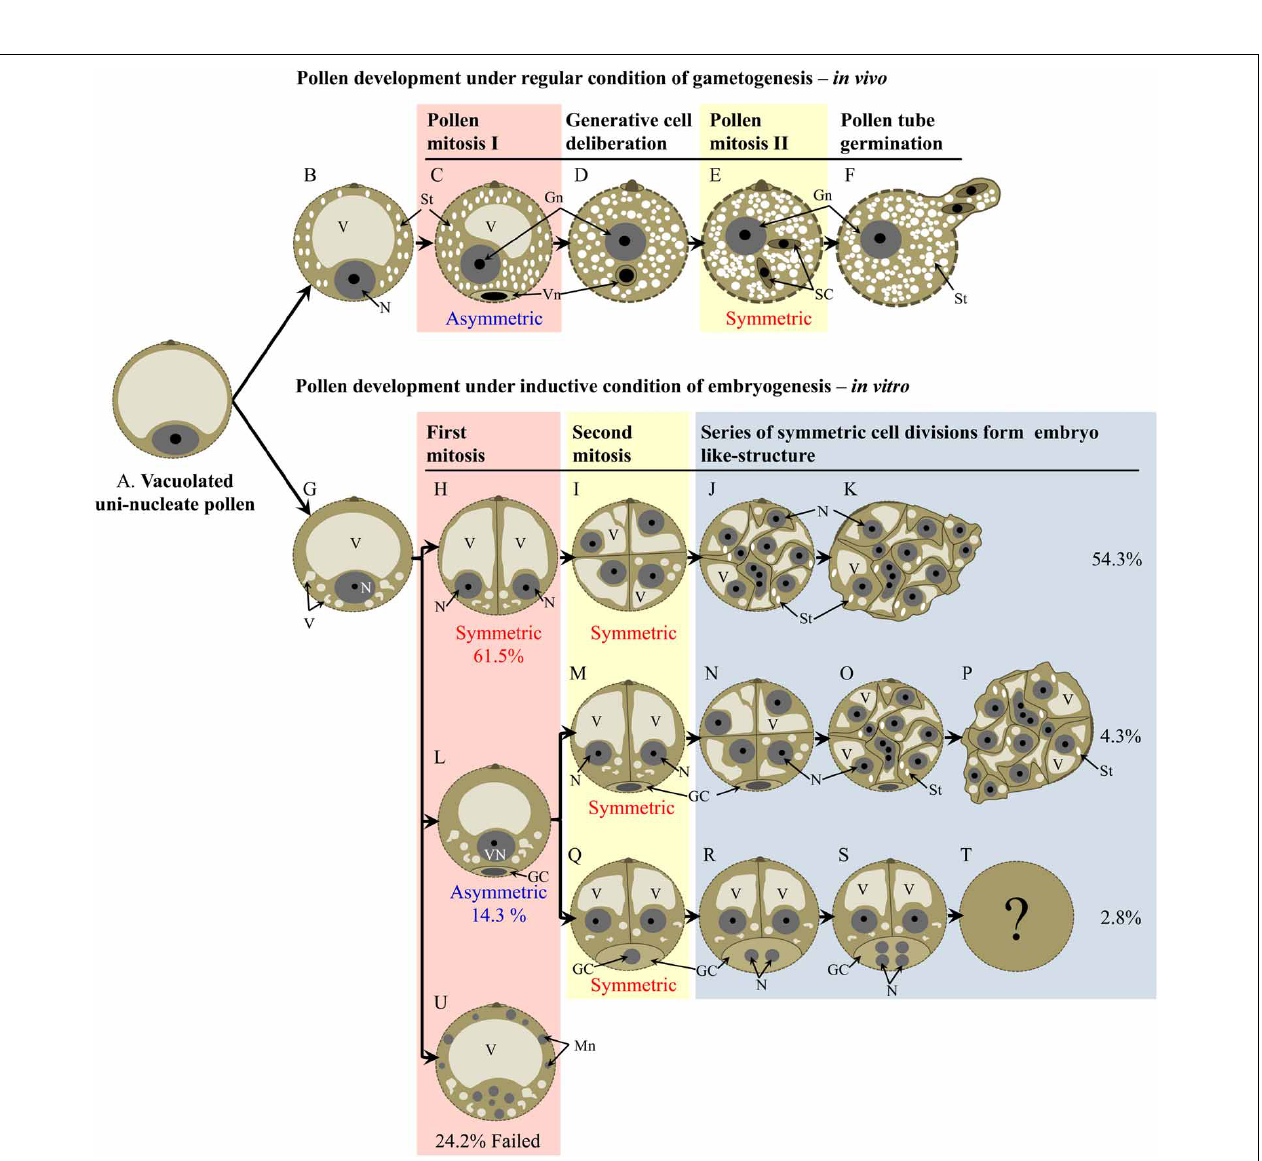
FIGURE 9 | Schematic model of main developmental routes of pollen during regular maturation and pollen embryogenesis. (A) premitotic microspore, (B) commencement of starch accumulation in premitotic microspore, (C) product of asymmetric pollen mitosis I, (D) bicellular pollen withthegenerativecelldeliberatedfromthecellperiphery, (E) formationoftwo sperm via pollen mitosis II, (F) germination of mature pollen, (G) premitotic microspore with emerging small vacuoles, (H) bicellular pollen after symmetric 1st pollen mitosis, (I) 4-celled pollen after two rounds of symmetric cell divisions, (J) multi-cellular pollen, (K) pollen releasing proliferating tissue, (L) bicellular pollen after asymmetric 1st pollen mitosis, (M) tri-cellular pollen after symmetric division of the vegetative-like cell, (N) 5-celled pollen including a